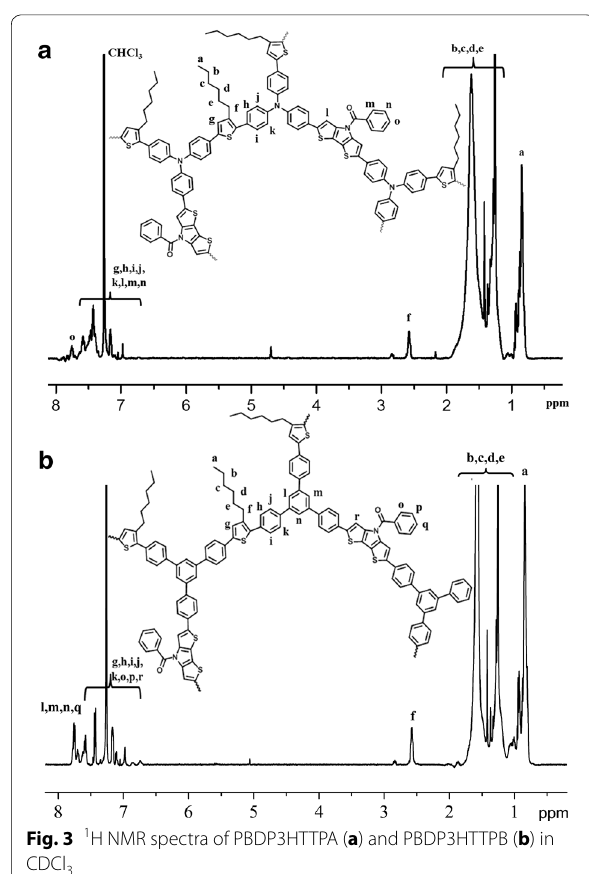
Fig. 3 1 H NMR spectra of PBDP3HTTPA ( a ) and PBDP3HTTPB ( b ) in CDCl